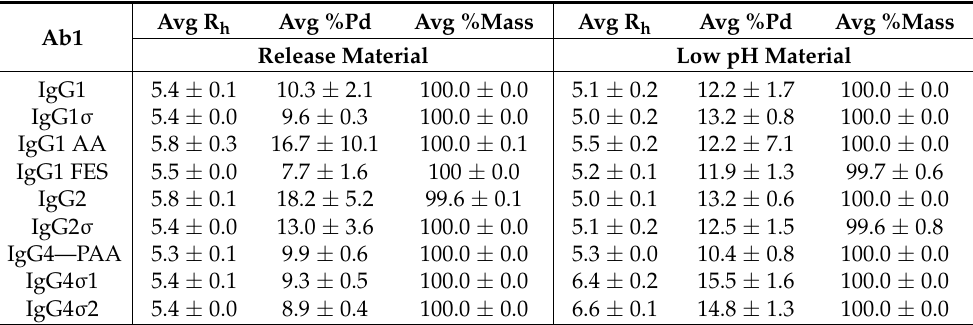
Table 6. Dynamic light scattering data after low pH